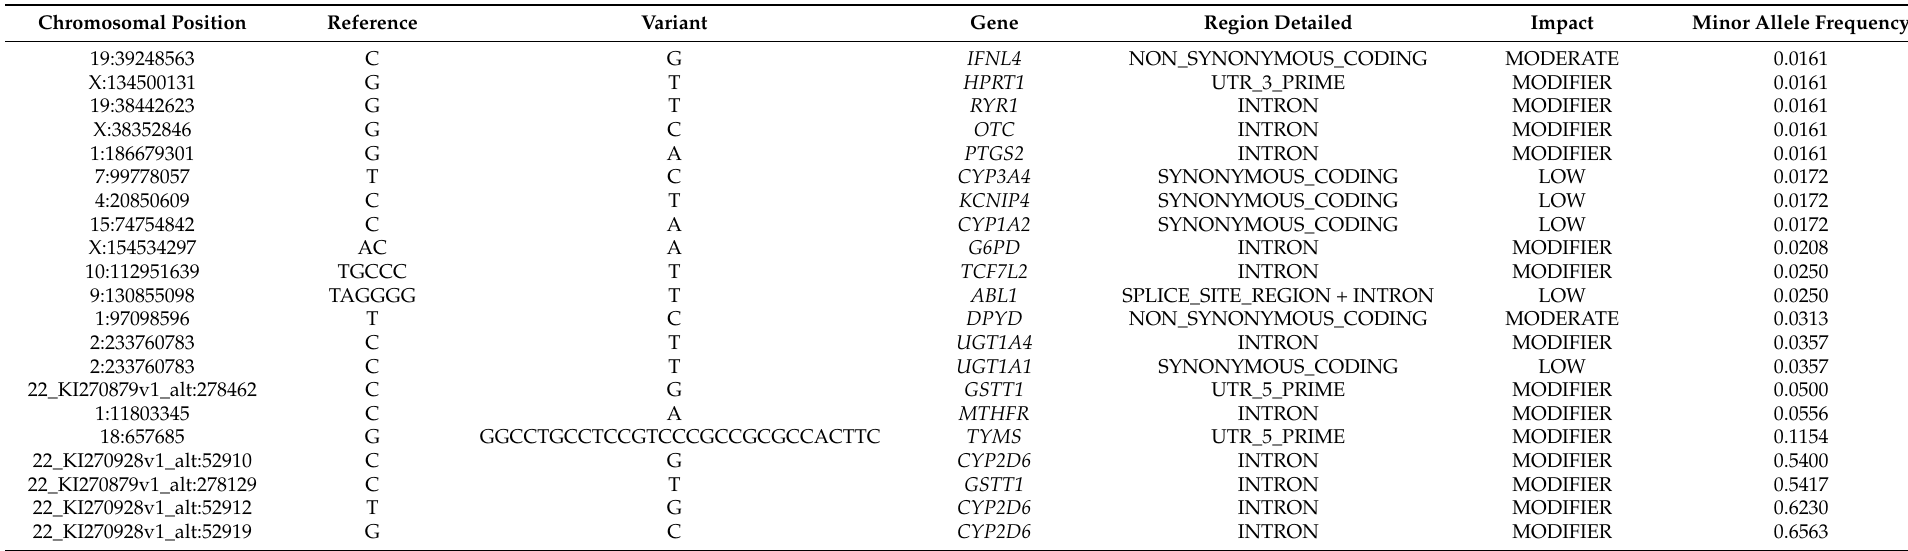
Table 2. Novel variants reported in the Amazonian Amerindians with minor allele frequency greater than